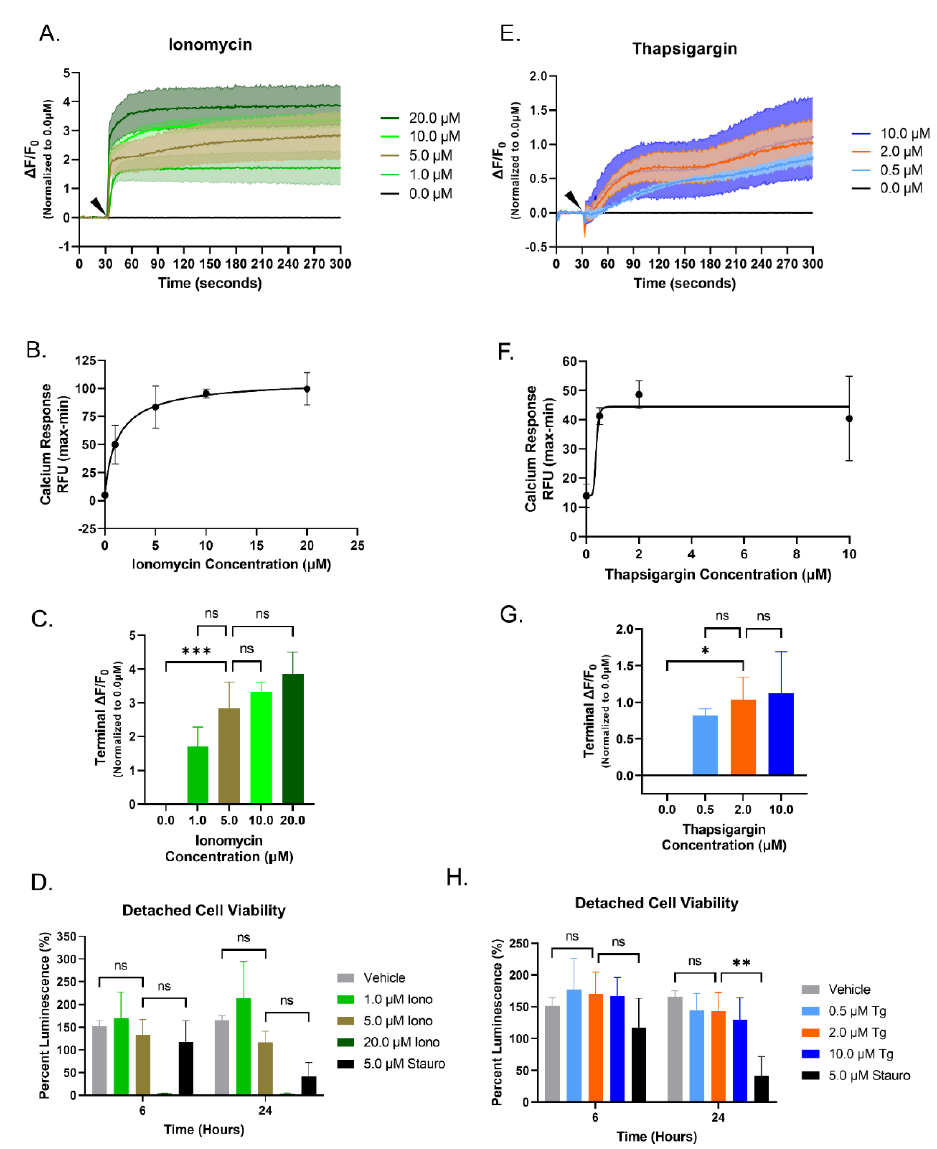
Figure 1. Ionomycin and Thapsigargin cause an increase in cytoplasmic Ca 2+ in a dose-dependent manner in MDA-MB-231 cells. ( A – C , E – G ) After a 30 s basal recording of fluorescence (Ex494 nm; Em: 516 nm), an arrow indicates the increasing concentrations of Ionomycin or Thapsigargin that were added and continually recorded for an additional 270 s. Relative fluorescence unit (RFU) data was analyzed in GraphPad Prism and presented as change in RFU divided by the initial RFU ( ∆ F/F 0 ). Data shown are mean ± SD and representative of 3 independent experiments performed in triplicate. ( A ) Traces of increasing cytoplasmic Ca 2+ ( ∆ F/F 0 ) of MDA-MB231 cells in response to the addition of increasing concentrations of Ionomycin. ( B ) EC50 Ca 2+ response curve (RFU) for increasing concentrations of Ionomycin. ( C ) Terminal ∆ F/F 0 value for each concentration of Ionomycin used. ( D ) MDA-MB-231 cell viability in a suspended state with different concentrations of Ionomycin treatment over a 24 h time course. ( E ) Increasing cytoplasmic Ca 2+ response ( ∆ F/F 0 ) traces to the addition of increasing Thapsigargin concentrations. ( F ) EC50 Ca 2+ response curve (RFU) of MDA-MB-231 cells for increasing concentrations of Thapsigargin. ( G ) Terminal ∆ F/F 0 value for each concentration of Thapsigargin. ( H ) Cell viability of MDA-MB-231 cells in suspension with increasing concentrations of Thapsigargin treatment over 6- and 24- hour treatment. ( D , H ) Data shown are mean ± SD and representative of 3 independent experiments performed in triplicate. n.s., * p < 0.05, ** p < 0.01, and *** p <